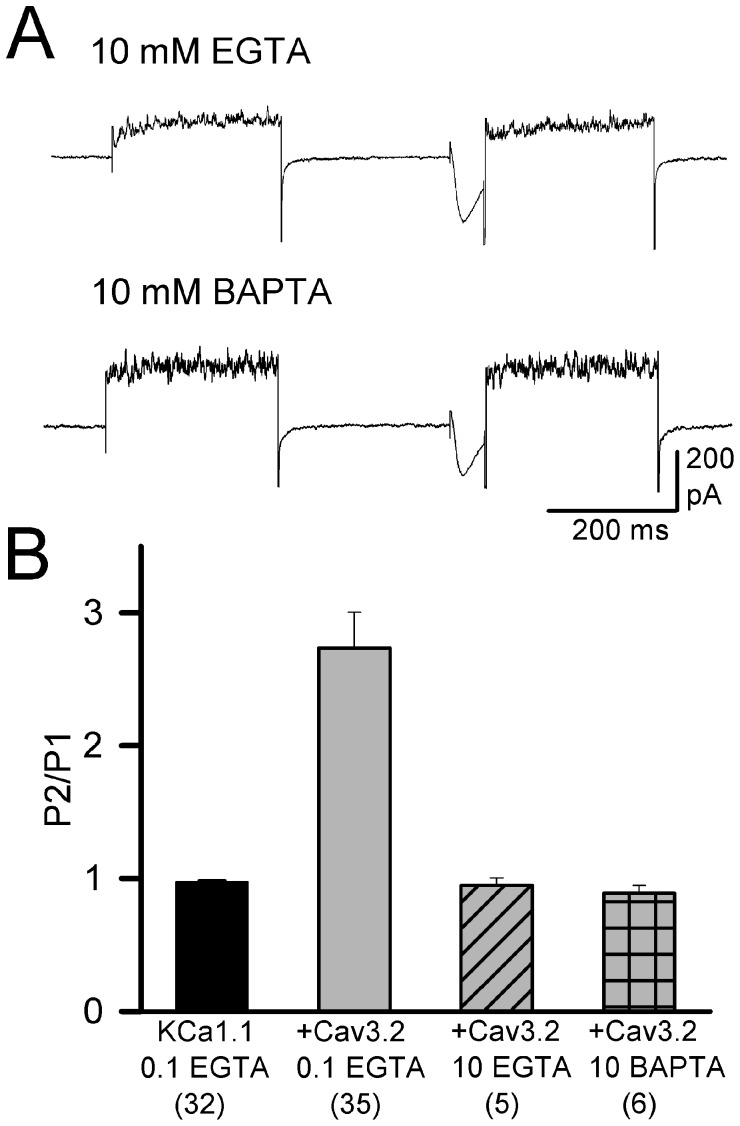
Effects of intracellular calcium buffering on KCa1.1 channel recruitment by Cav3 calcium influx.
A, Shown are whole-cell recordings from transiently transfected tsA-201 cells, demonstrating the effects of intracellular calcium buffering by 10 mM of EGTA or BAPTA on KCa1.1 current when coexpressed with Cav3.2 channels. B, Bar plots indicating the fold change in peak KCa1.1 current (P2/P1) under the indicated conditions of internal calcium chelation when coexpressed with Cav3.2 channels. Calcium entry via Cav3.2 channels increases KCa1.1 channel activity in the presence of internal 0.1 mM EGTA or 0.1 mM BAPTA, but not in the presence of 10 mM of either calcium chelator, or with alternate expression of the nonconducting Cav3.2pm. Sample sizes are shown in brackets.